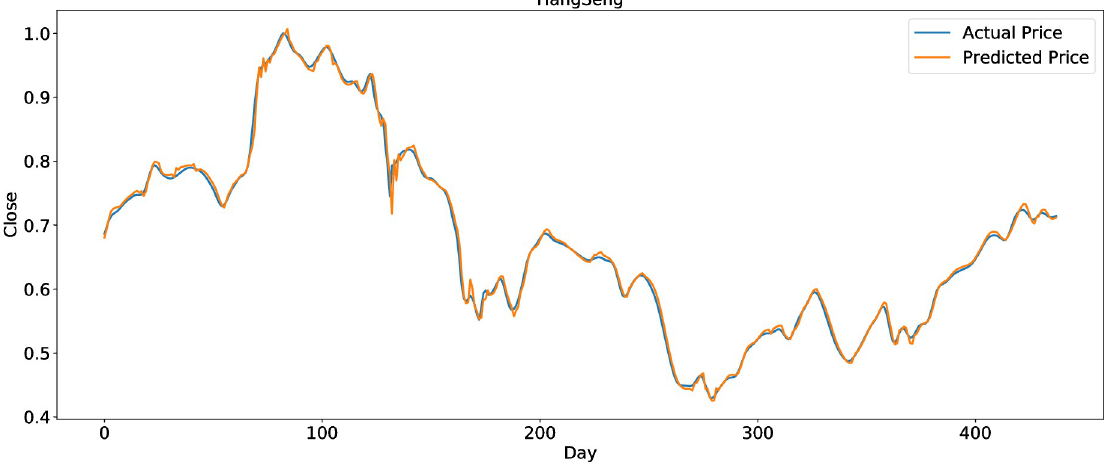
Fig 14. Prediction results of HangSeng data